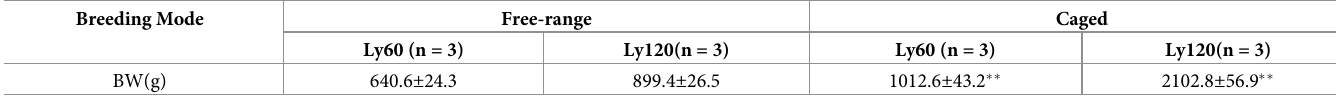
Table 1. Live body weights in free-range and caged chickens. Breeding